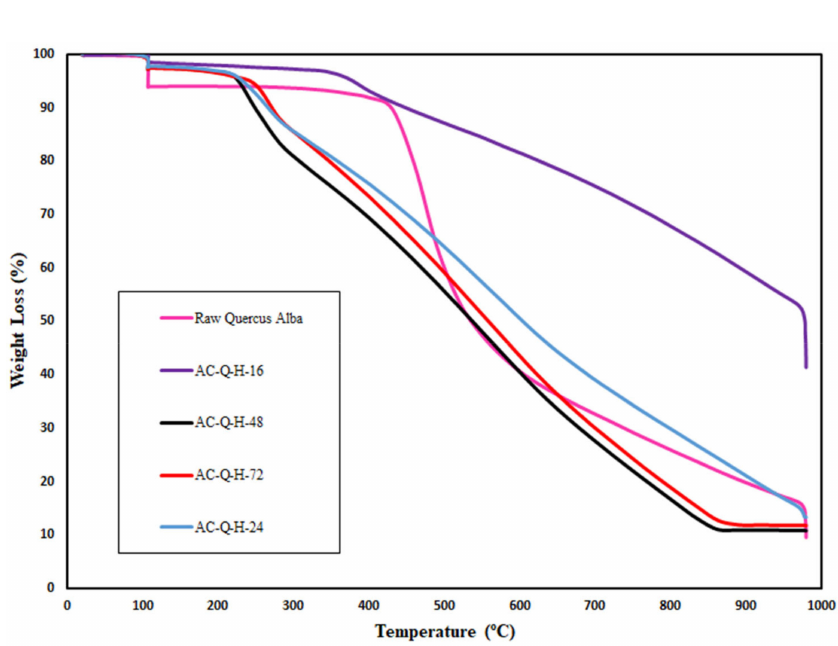
Figure 5. TGA analysis of activated